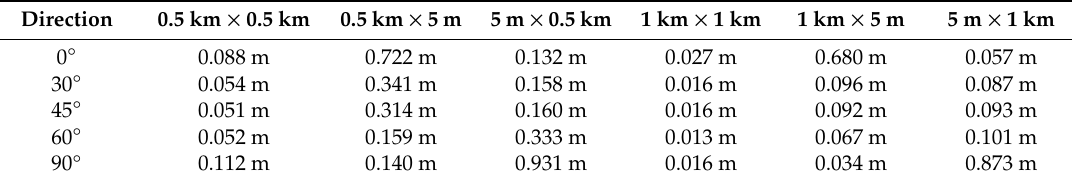
Table 11. The RMS of smoothing layover height inversion results with di ff erent swell propagation directions (the direction of the smoothing window is in two directions at the same time, in the azimuth and in the range).